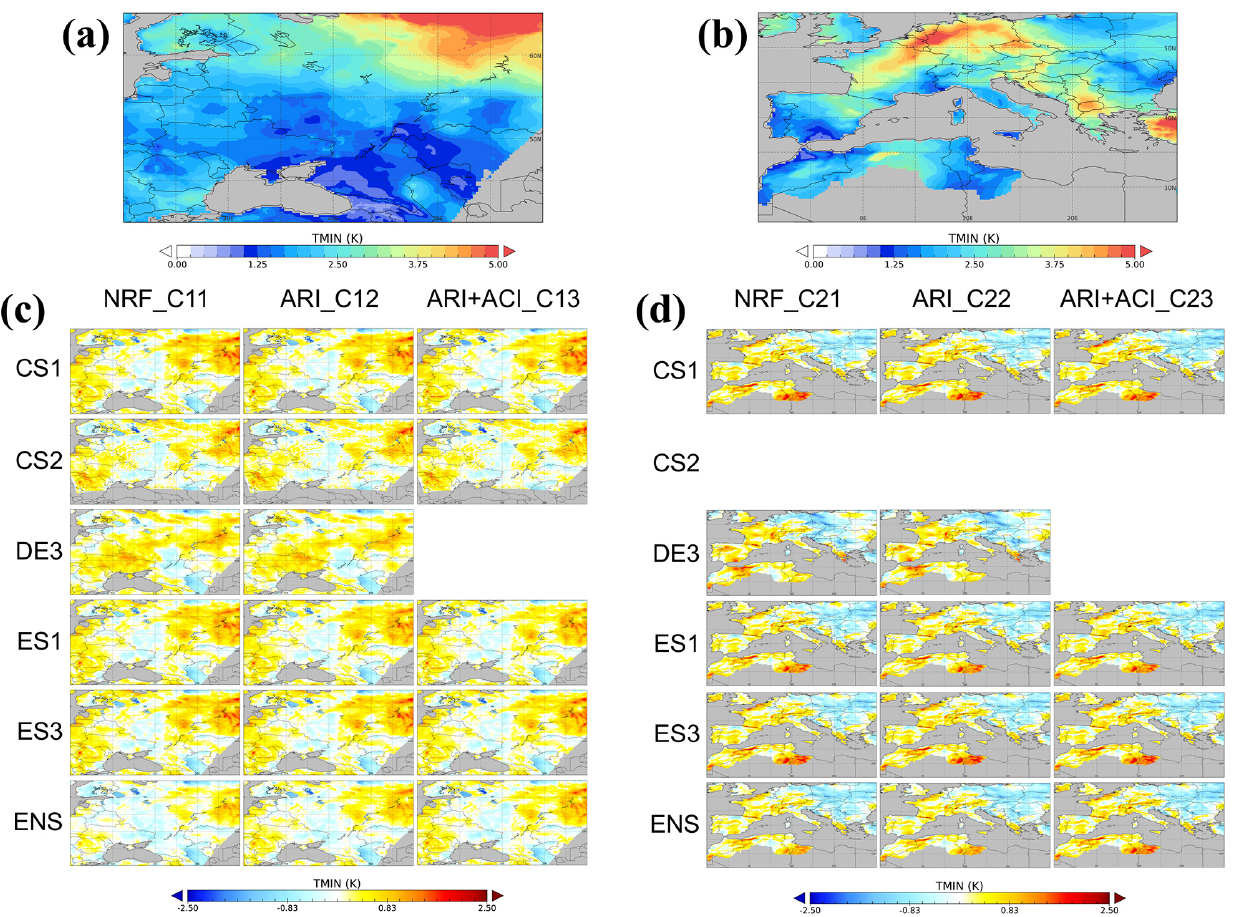
Figure 10. Standard deviation (SD) of the minimum temperature (TMIN) for the fire (a) and dust (b) episodes, as derived from the E-OBS database (in K). The panels below represent the bias for the standard deviation of the fires (c) and dust (d) episodes of each simulation with respect to the E-OBS